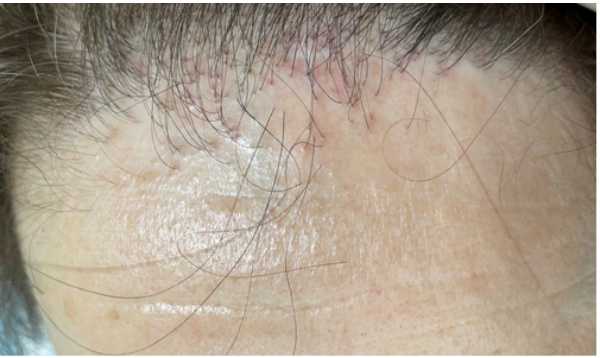
Figure 3. Lichen planopilaris clinical aspect: permanent hair loss located at the frontal level. No hair follicle openings can be seen in the area of hair loss. Scale and redness surround each hair follicle in the area of hair loss.